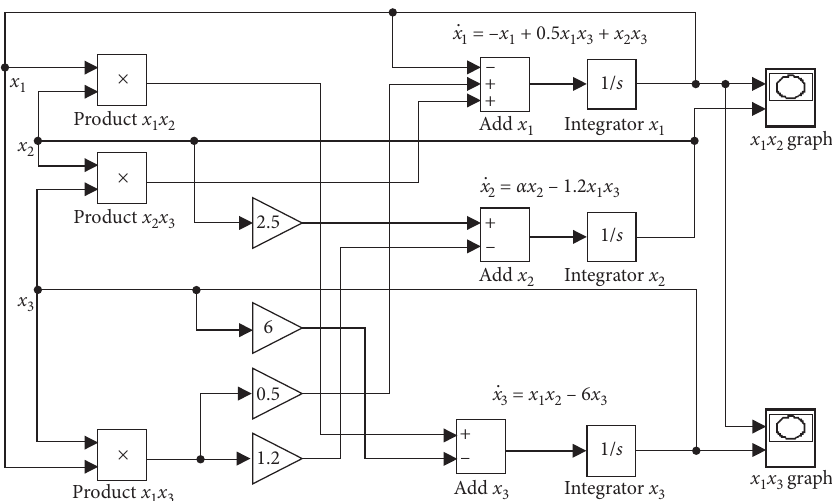
Figure 2: Implementation of system (1) realized by using the block diagram in the MATLAB simulink